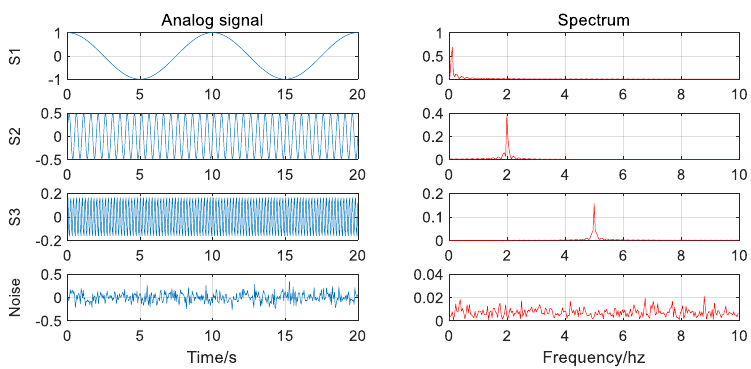
Figure 5. Signal waveform and corresponding spectrogram (with noise).